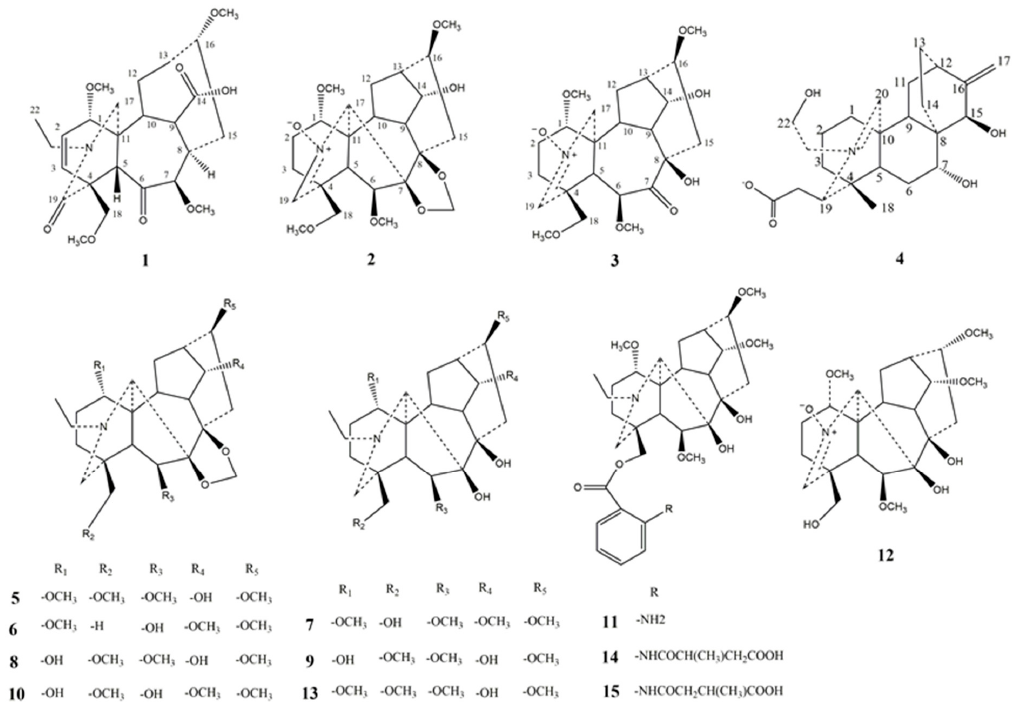
Figure 1. The structures of compounds 1 – 15 isolated from D. brunonianum.